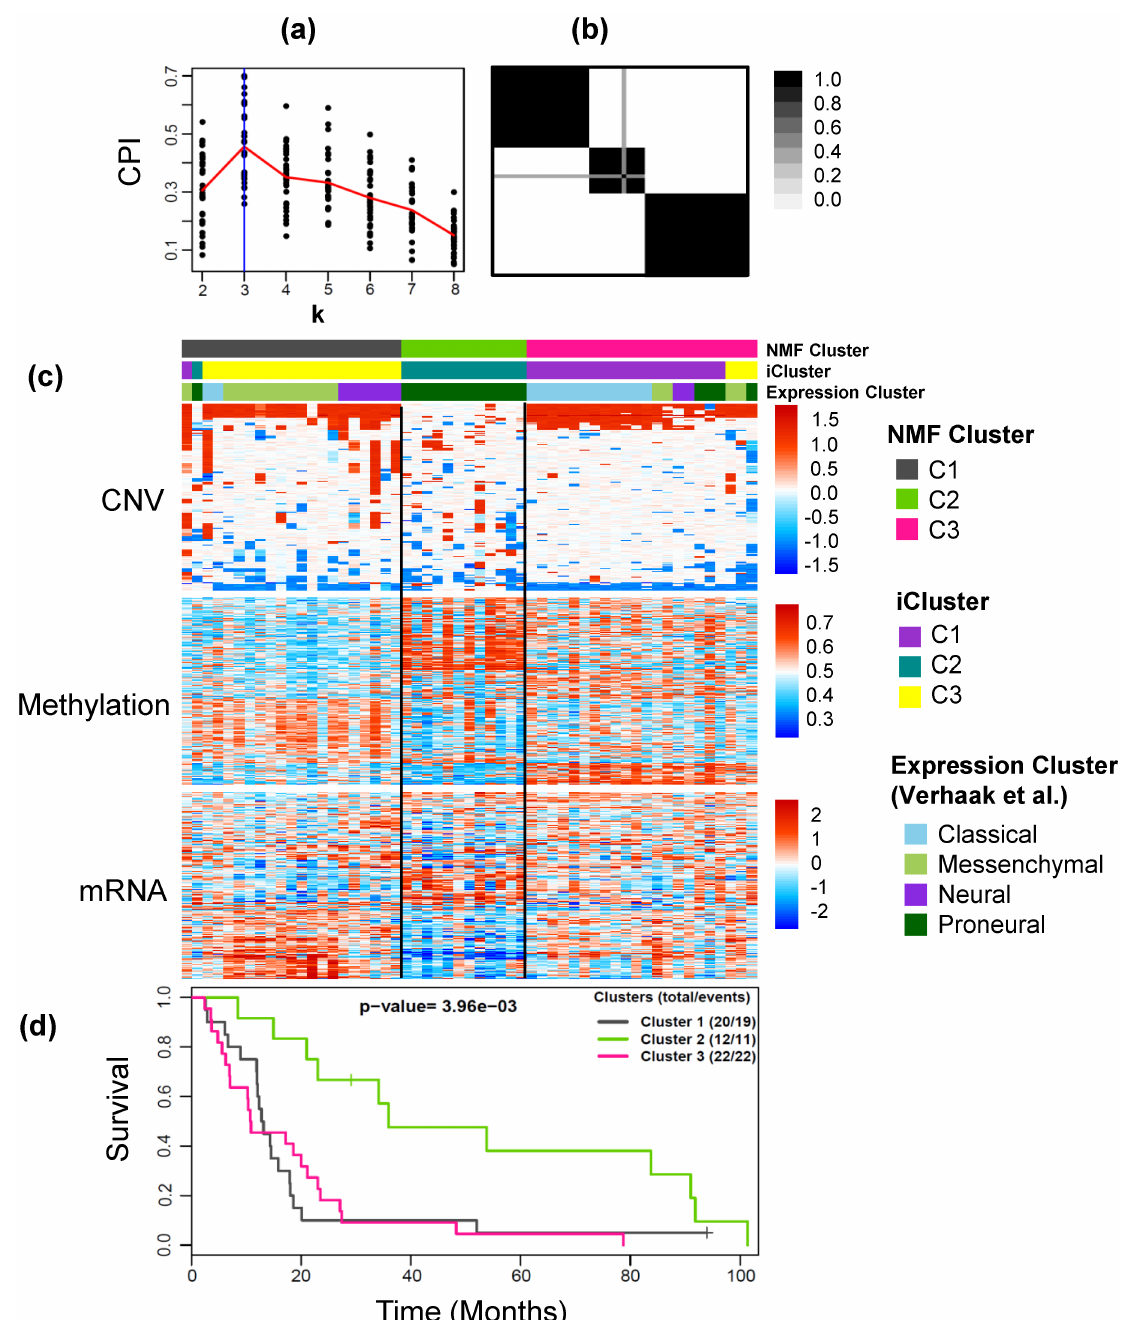
Fig 4. Example 2: Glioblastoma data. (a) Plot of CPI over the search range of number of clusters from 2 to 8 for 30 runs of intNMF algorithmat each k . The red line represents the mean values of CPI at each k . (b) The cluster pattern as shown by the consensus matrix. (c) Heatmap of three types of data, CNV, Methylationand mRNA with clusteringassignmentfrom intNMF, iCluster and Expression subtypesoverlaidon top with legendson the side. (d) KaplanMeier Survival curves with p-value from